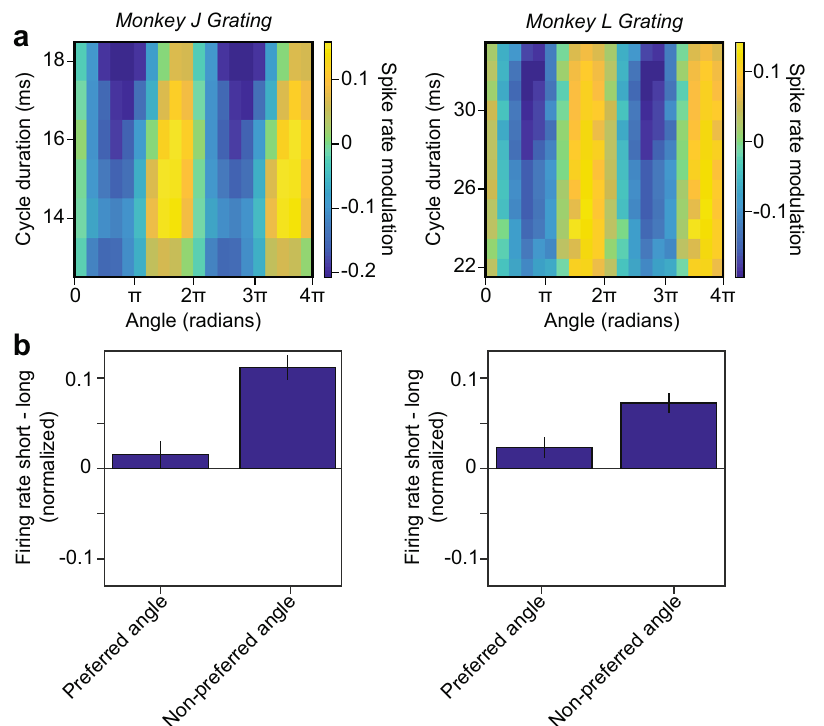
Fig. 7 The modulation of spiking activity by the phase of the gamma cycle. a The colormap shows the modulation of the MU fi ring rate as a function of gamma-cycle duration (y-axis) and the phase in the gamma cycle, at which spikes occurred (x-axis). Same n ’ s as in Fig. 6a. b Difference in normalized fi ring rate between short and long gamma cycles for the preferred (left bar) and non-preferred phase in gamma cycles (right bar). Vertical lines depict ±2 SEM across units. Data from monkey J and monkey L are shown in the left and right column, respectively. Same n ’ s as in Fig. 6a. The fi ring rate increase for short compared to long cycles at the non-preferred gamma phase is higher than at the preferred gamma phase both for monkey J and L (two-sided t -test: p = 4.2 × 10 − 6 and p = 0.0029 respectively). Source data are provided in the Source Data fi